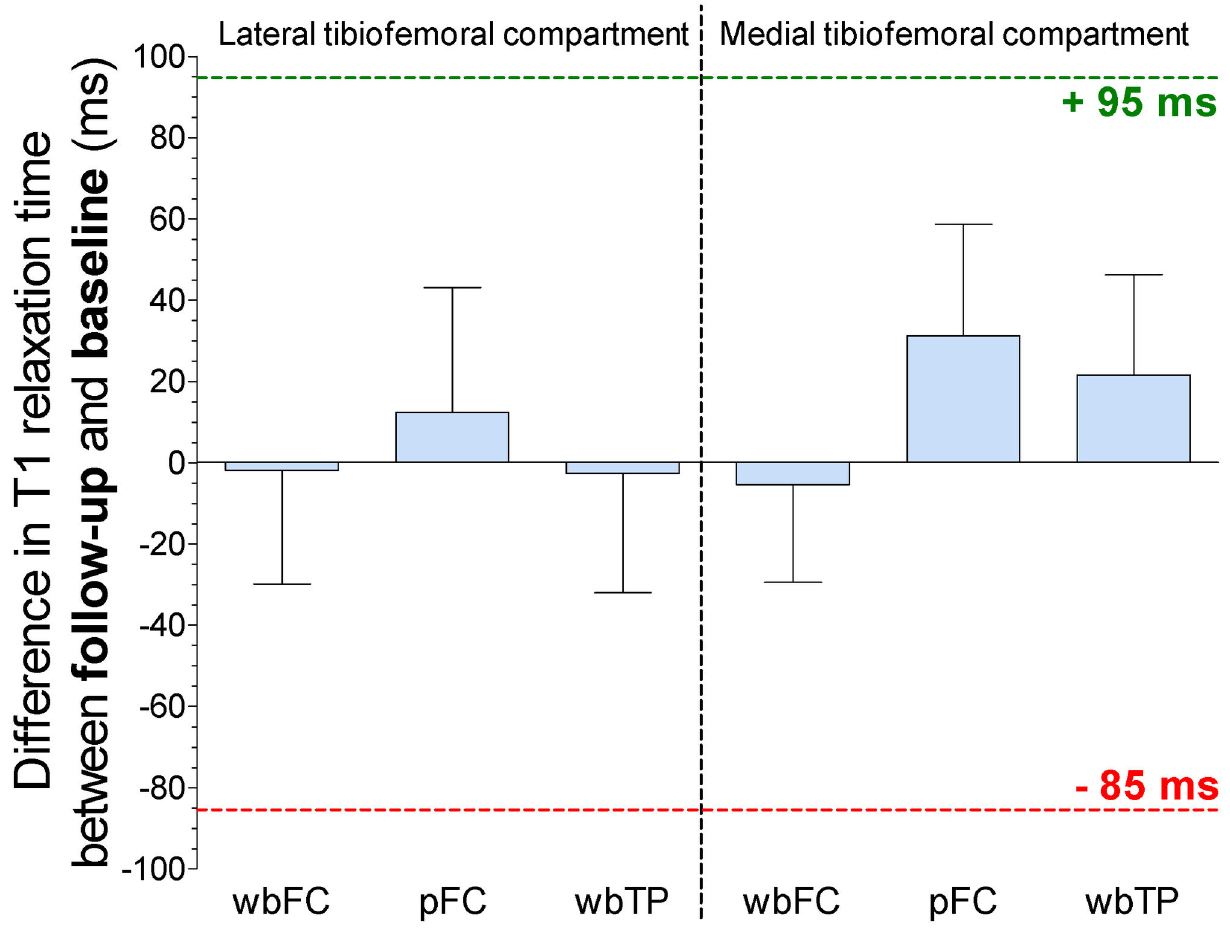
Figure 3. Differences between dGEMRIC T1 relaxation times at baseline and follow-up. Bar graphs showing the differences in dGEMRIC T1 relaxation times in each anatomical cartilage ROI at follow-up, 14 weeks after HA injections compared to baseline. The bar represents the mean and the whiskers represent the 95% confidence interval for the mean. +95 ms: clinically relevant threshold for improvement in cartilage sGAG content if a single patient is followed over time using dGEMRIC [24]. -85 ms: clinically relevant threshold for impairment of cartilage sGAG content if a single patient is followed over time using dGEMRIC [24]. wbFC: weight-bearing cartilage of the femoral condyle. pFC: posterior non weight-bearing cartilage of the femoral condyle. wbTP: weight- bearing cartilage of the tibial